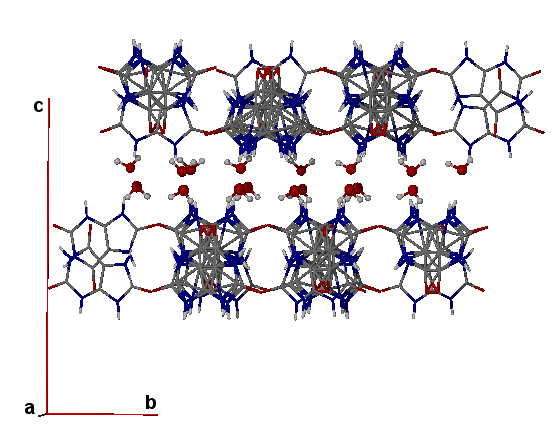
Figure 6. Discrete water layer in uric acid